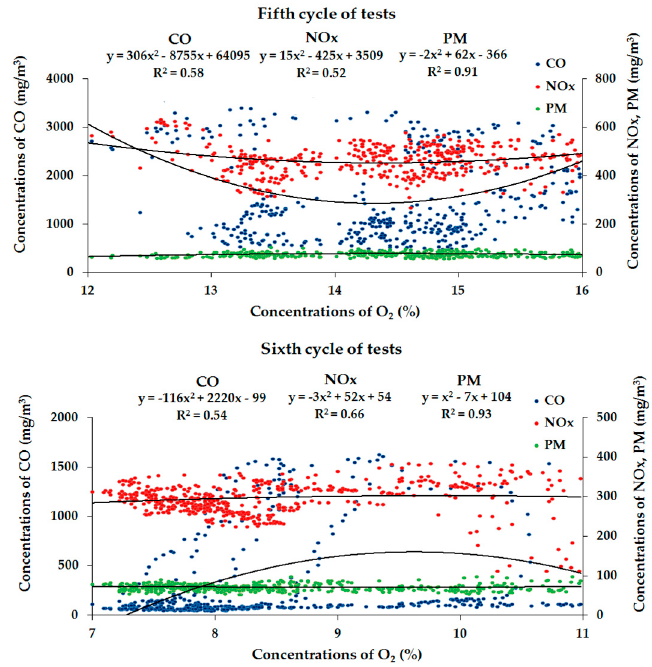
Figure 7. Mass distribution of harmful substances to the remaining amount of oxygen for the fifth and sixth cycle of tests.